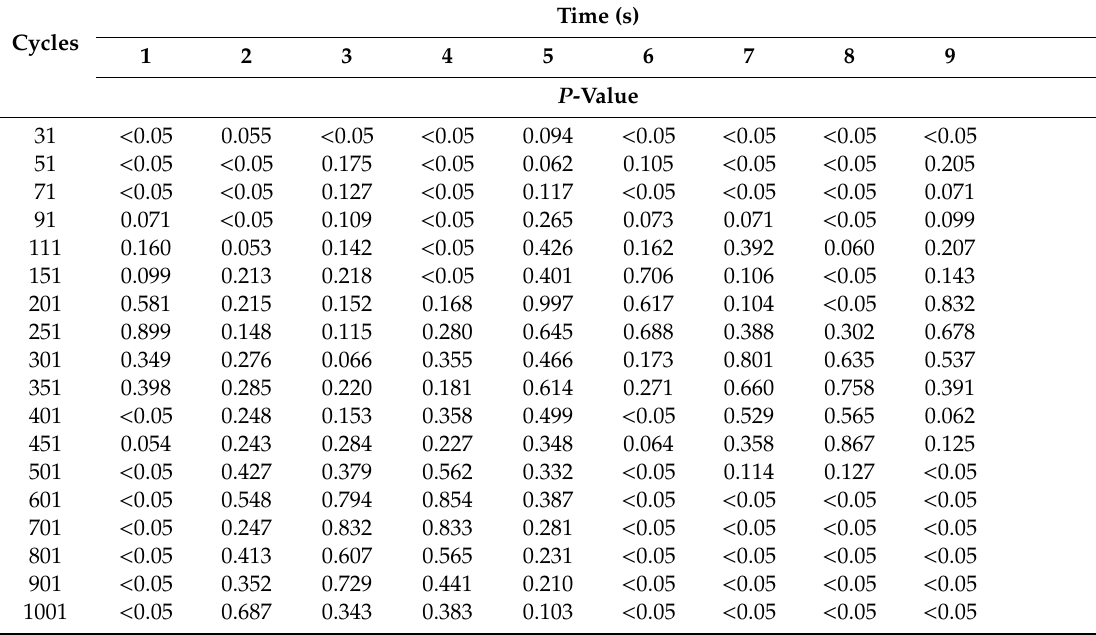
Table A1. Result of the equal variance test between T Thc and T Rec for 18 candidate